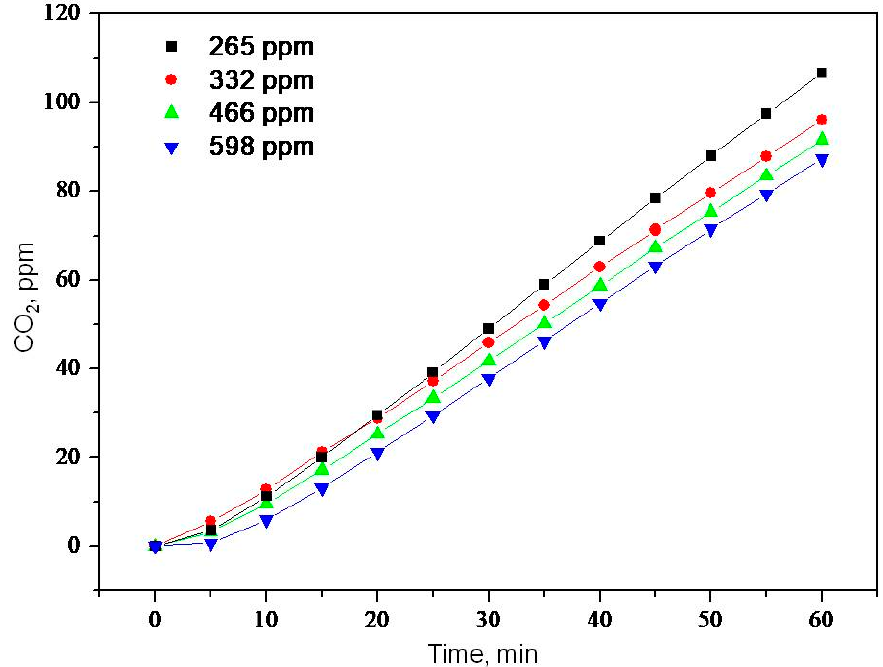
Figure 5. Photocatalytic degradation of isooctane (as CO 2 produced) determined at different initial concentrations of the substrate. TiO 2 (P25, Degussa) commercial powder is used. The experimental error is ≤ 10%.